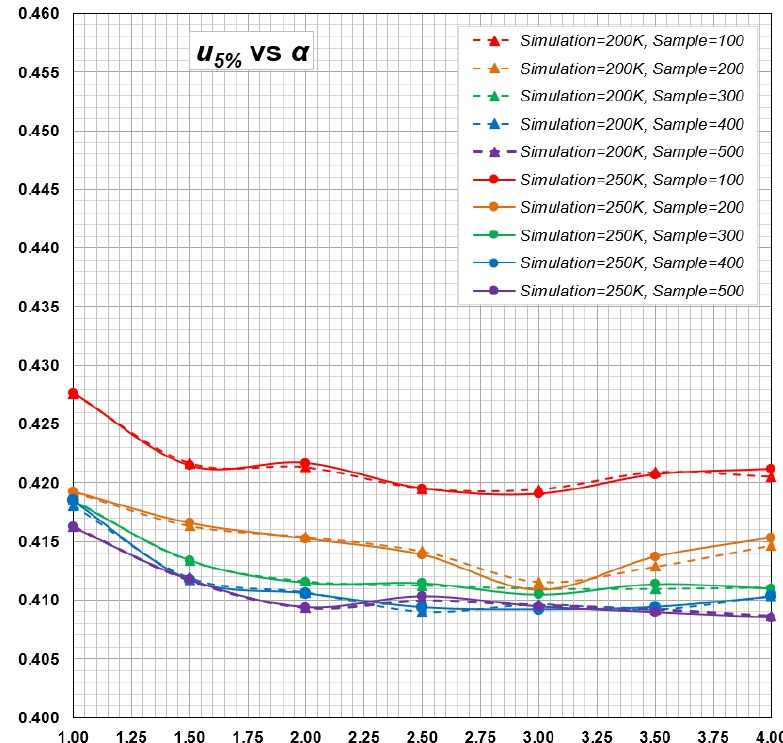
Figure A2. Critical values 𝐮 𝛄 versus shape parameters 𝜶 and sample sizes 𝒏 with 200,000 and 250,000 simulations.